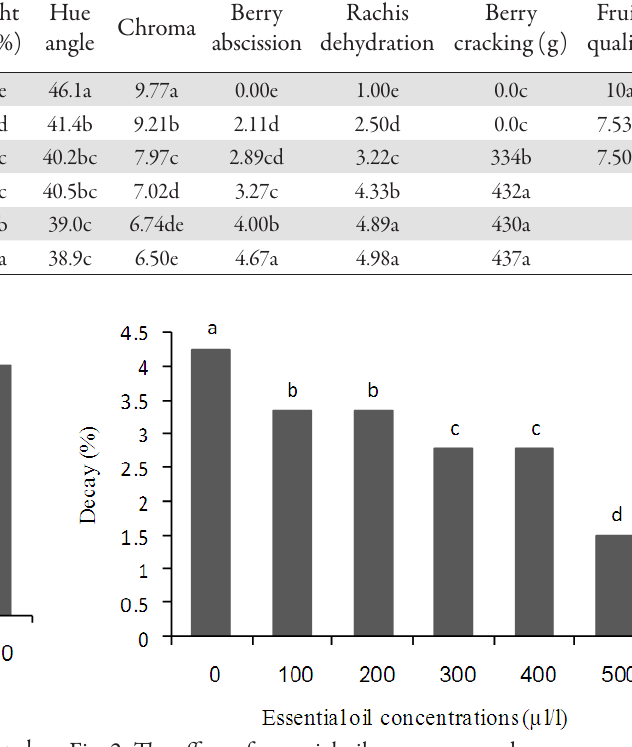
Fig. 1. The effect of essential oil treatment on pH of ‘Bidaneh Qermez’ table grape